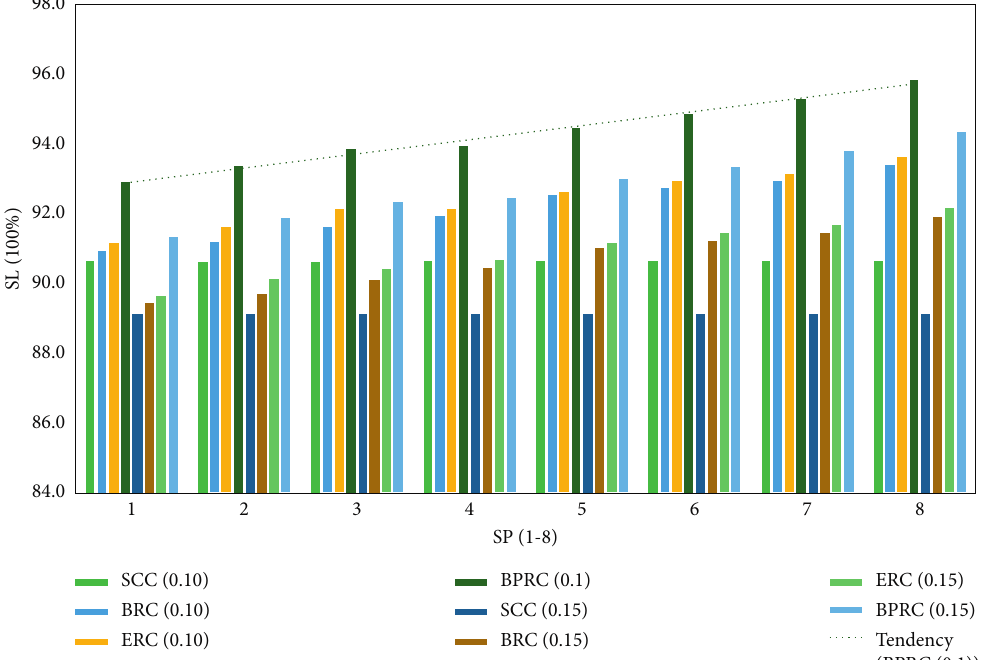
Figure 11: Service level affected by